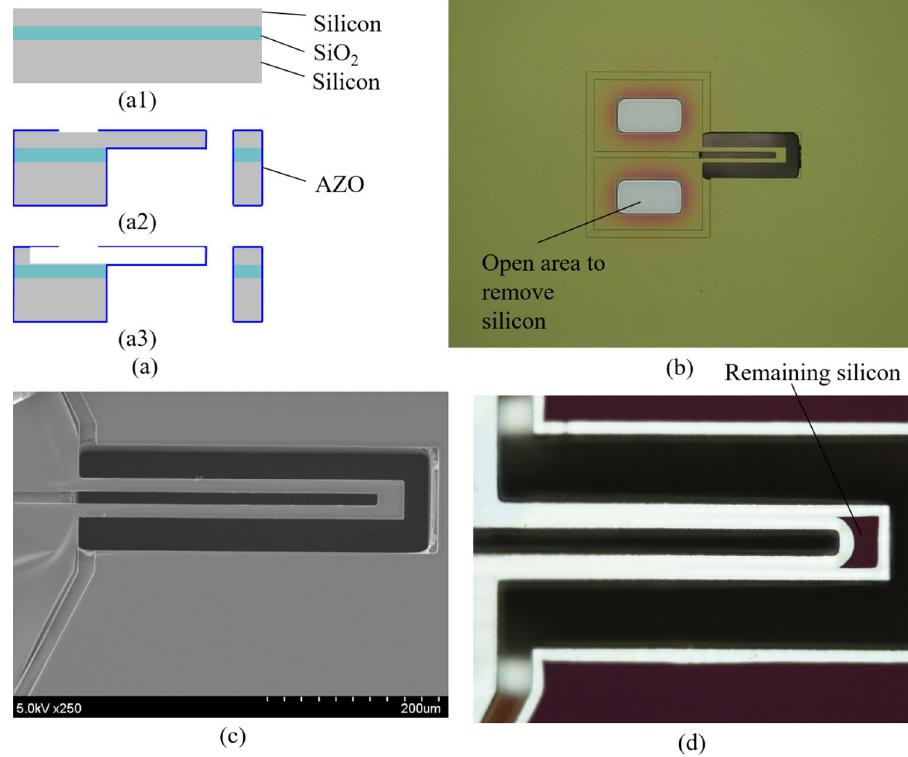
Figure 4. Hollow fluidic channel. ( a ) Fabrication process. ( a1 ) SOI wafer. ( a2 ) Silicon cantilever with a patterned coating AZO. ( a3 ) Removal of silicon structure. ( b ) Optical image of a silicon cantilever